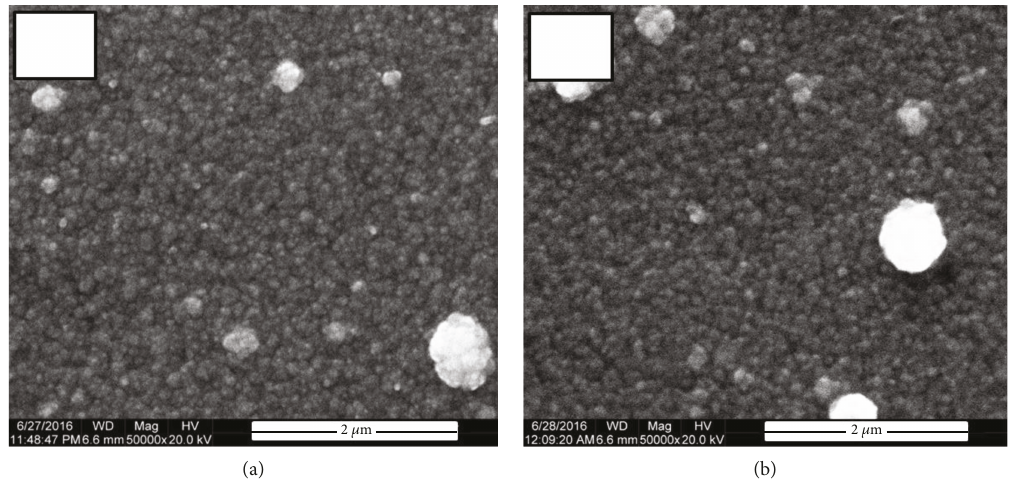
Figure 4: SEM micrographs of CdS thin fi lms: (a) as deposited (sample A) and (b) annealed at 400 ° C (sample